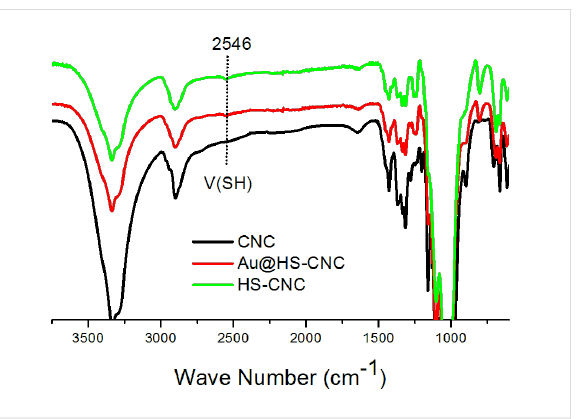
Figure 4: FT-IR spectra of CNC, HS-CNC, and Au@HS-CNC (4.4 mol %)